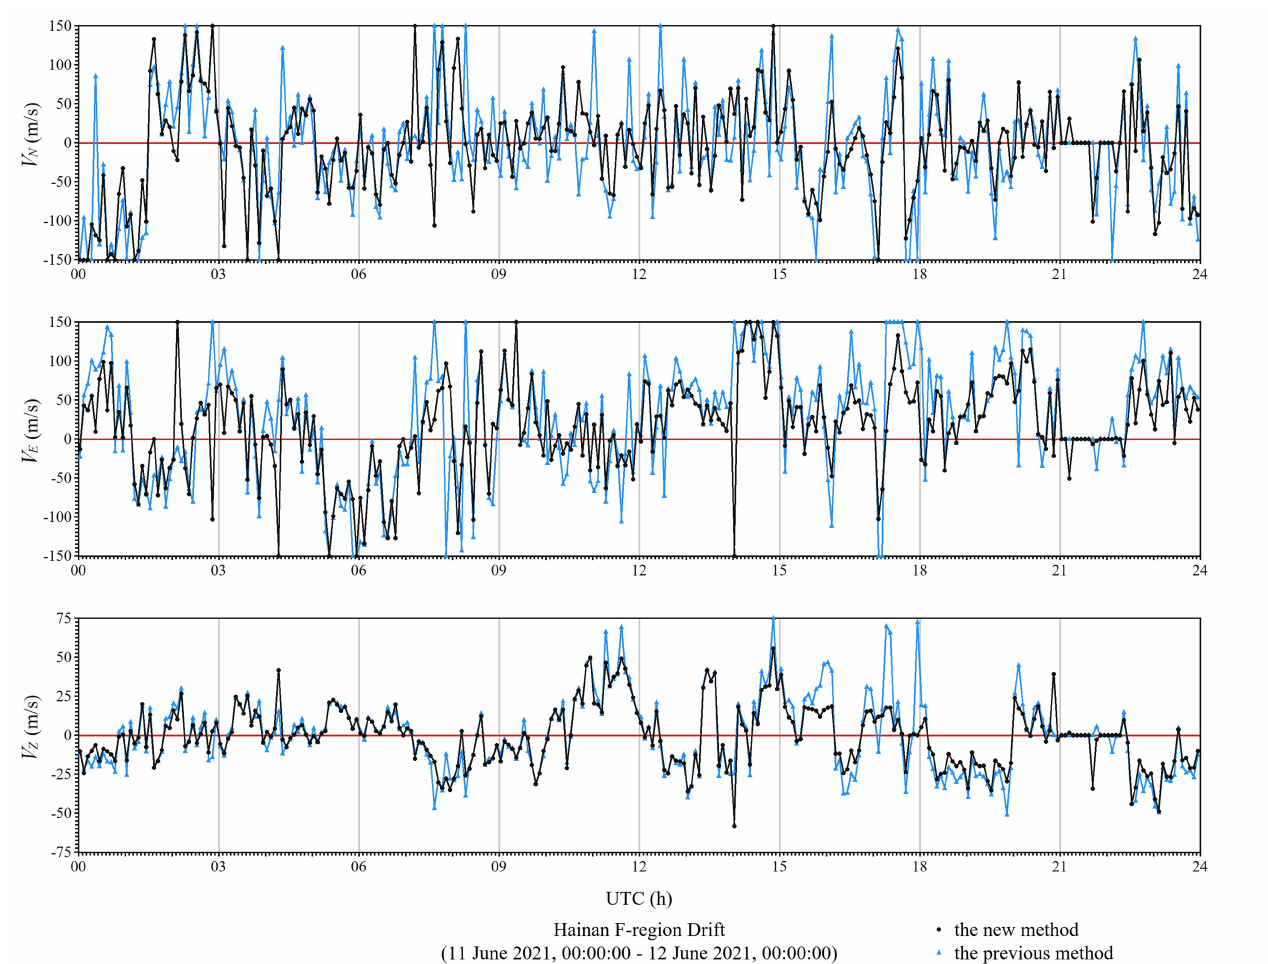
Figure 8. Statistics of the F-region drift velocity in Hainan from 11 June 2021, 00:00:00 to 12 June 2021, 00:00:00 in